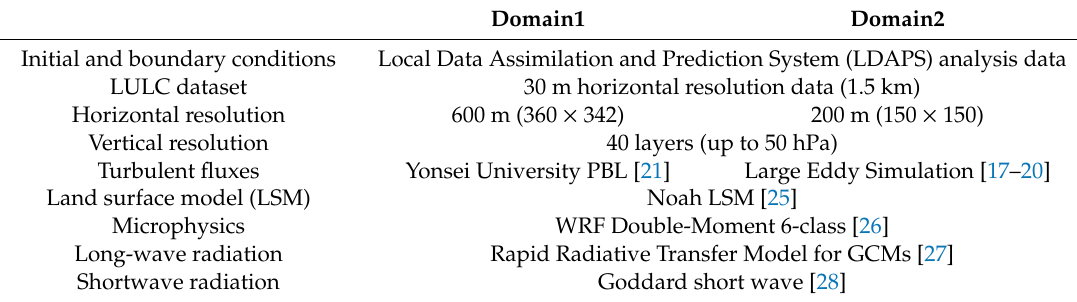
Figure 1. Maps of topography height of Domain1 and Domain2 which cover the area of Gumi Weir in the Nakdong River. Domain2 includes 6 Automatic Weather Stations (circles) and the measurement site of water surface temperature (triangle). Table 1. Summary of Weather Research and Forecasting (WRF)